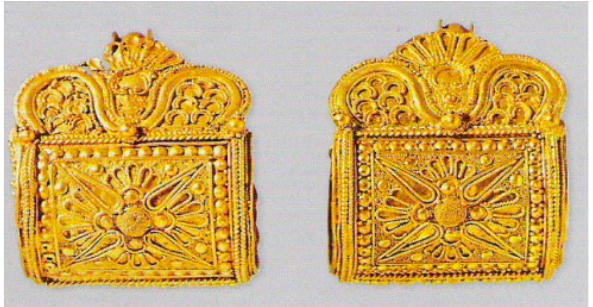
Figure 4. Pair of earrings, Museum of Villa Giulia N.Inv. 53580 and 53582.